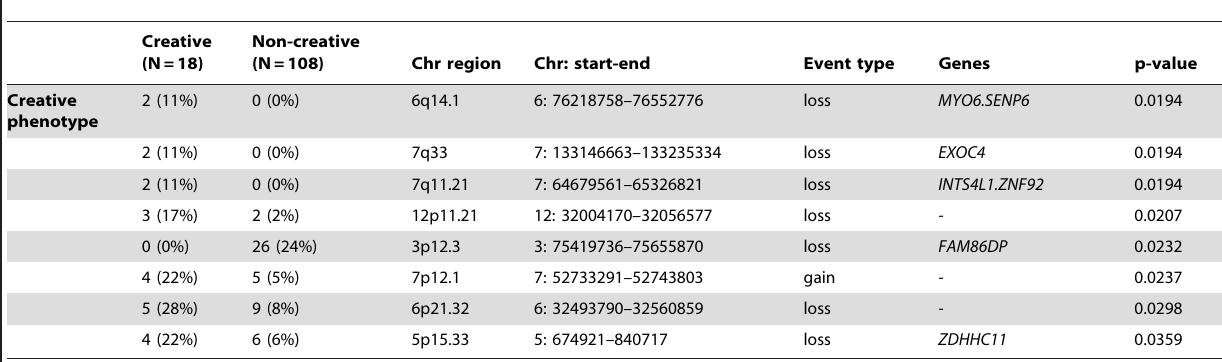
Table 5. Association of CNVRs with creative functions in music in the unrelated